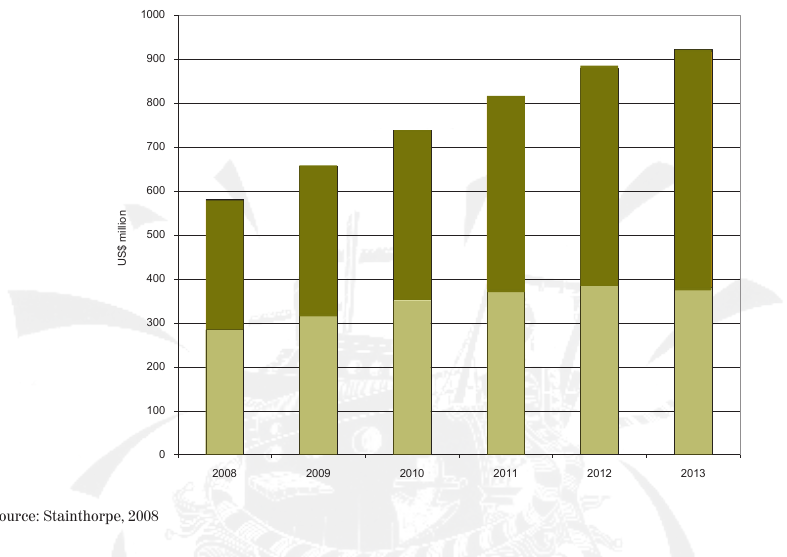
FIGURE 4: TOTAL OUTBOUND ROAMING REVENUES OF AFRICAN